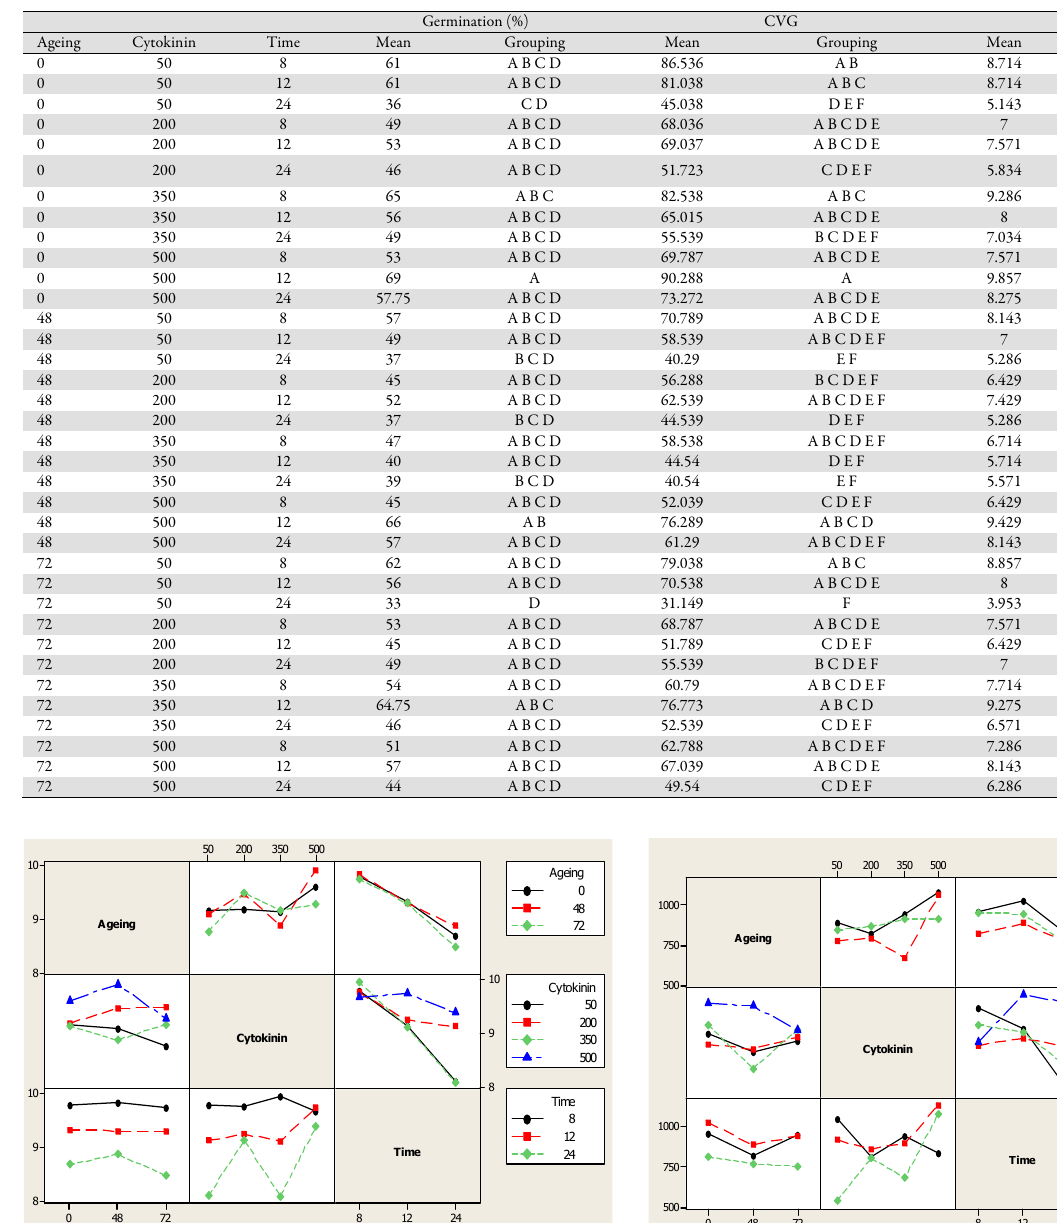
Table 5. Mean comparison of interaction of ageing, priming duration and cytokinin concentrations on germination percentage, CVG and MDG of Silybum